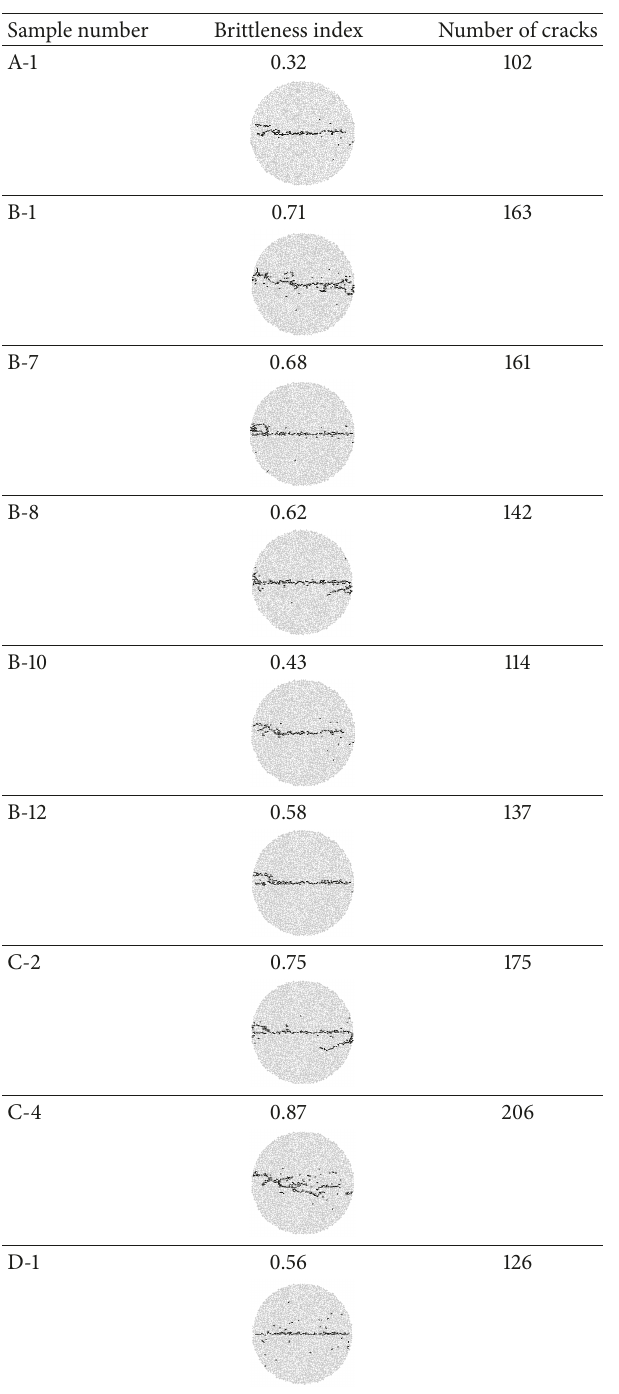
Table 6: Crack distribution characteristics of samples in numerical Brazilian splitting tests.